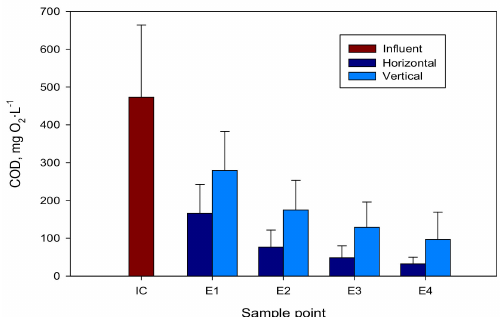
Figure 6. Evolution of the chemical oxygen demand along the treatment in the two pilot plants.